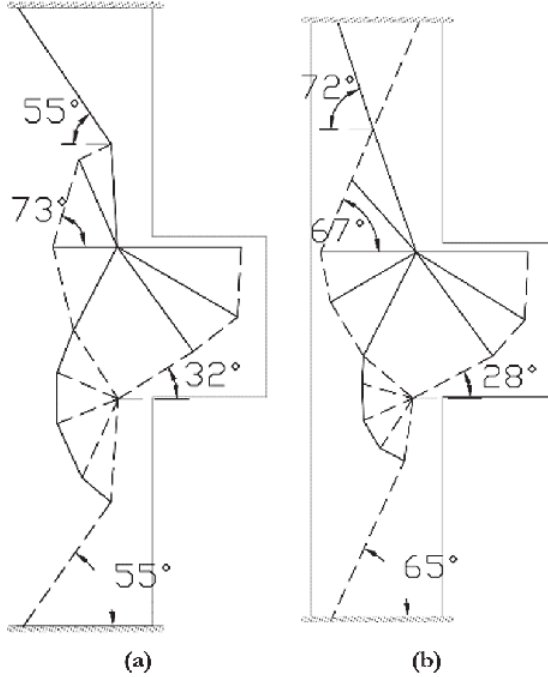
Figure 19 Strut-and-tie model (a) considering the linear behavior and (b) considering the nonlinear behavior. Dotted lines representing struts and continuous lines representing ties